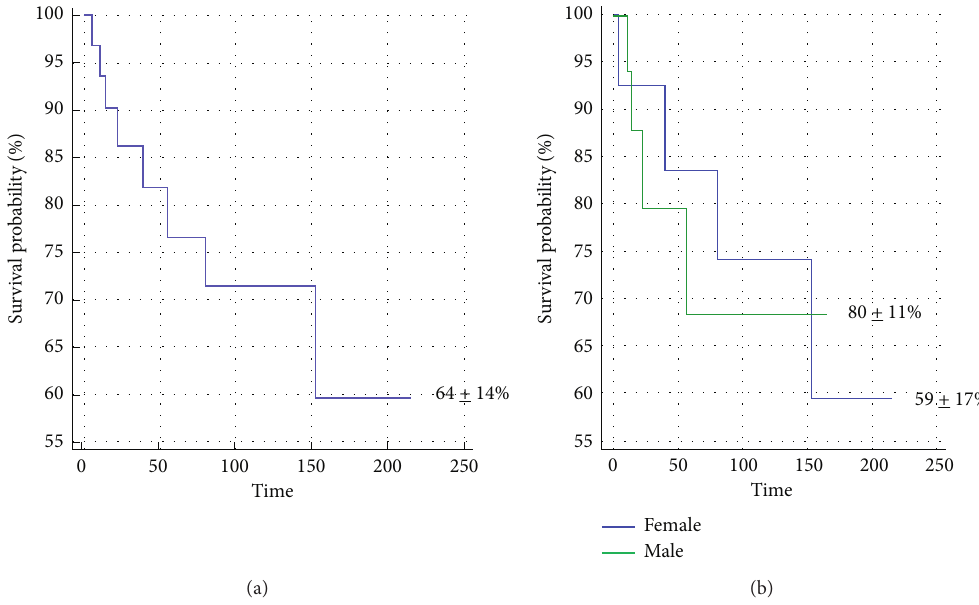
Figure 2: Kaplan–Meier survival curves. The graphs show Kaplan–Meier survival curves for the (a) entire cohort and for (b) males and females. (a) Overall sarcoma-specific survival in the entire cohort of 33 patients who underwent incomplete excision of an inguinal sarcoma was 64 ± 14% (time in months). (b) A comparison of sarcoma-specific survival curves between (1) females (59 ± 17%) and (2) males (80 ± 11%) who underwent incomplete excision of an inguinal sarcoma revealed no difference in long-term prognosis ( p � 0 . 885) (time in